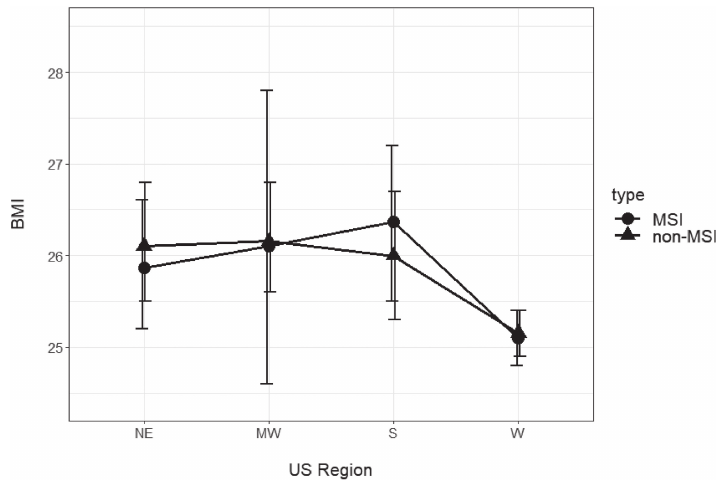
Fig. 3 Mean BMI of MSI versus non-MSI students by US region. Note: Results were mixed for MSI vs. non-MSI students (p = 0.15). NE MSI n = 2,212 (overweight / obesity prevalence = 45.2%); NE non-MSI n = 76,939 (overweight / obesity prevalence = 32.6%); MW MSI n = 956 (overweight / obesity prevalence = 45.7%); MW non-MSI n = 76,609 (overweight / obesity prevalence = 38.7%); S MSI n = 5,011 (overweight / obesity prevalence = 51.0%); S non-MSI n = 84,239 (overweight / obesity prevalence = 37.3%); W MSI n = 67,915 (over- weight / obesity prevalence = 42.2%); W non-MSI n = 91,106 (overweight / obesity prevalence =